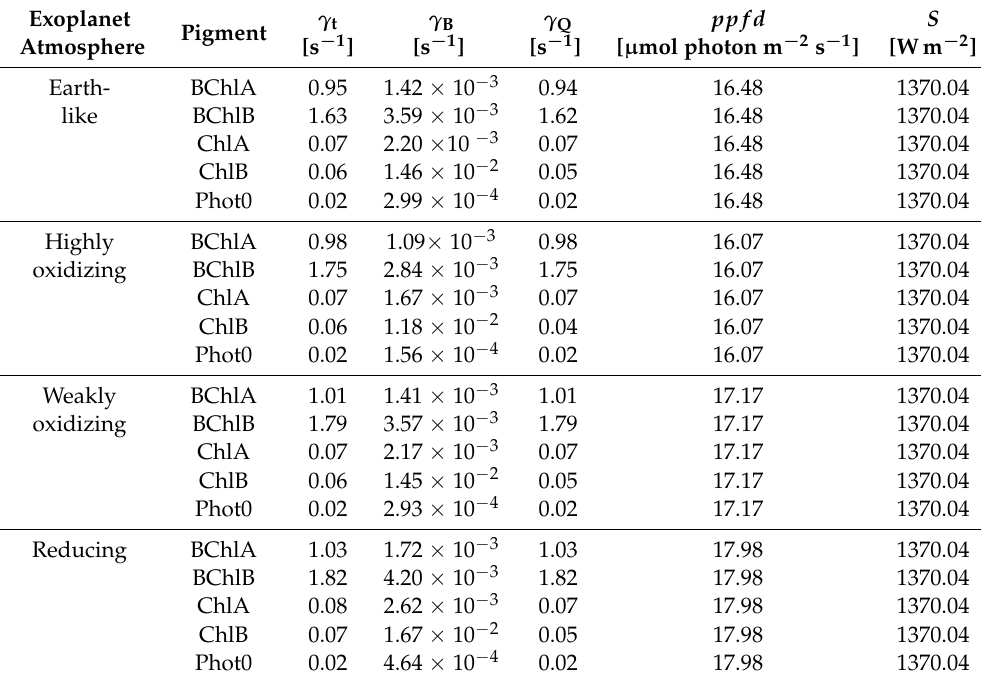
Table A4. Photosynthetic fitness metrics for Earth-like exoplanets with different atmospheres at the middle of the habitable zone (HZm) around a M8V